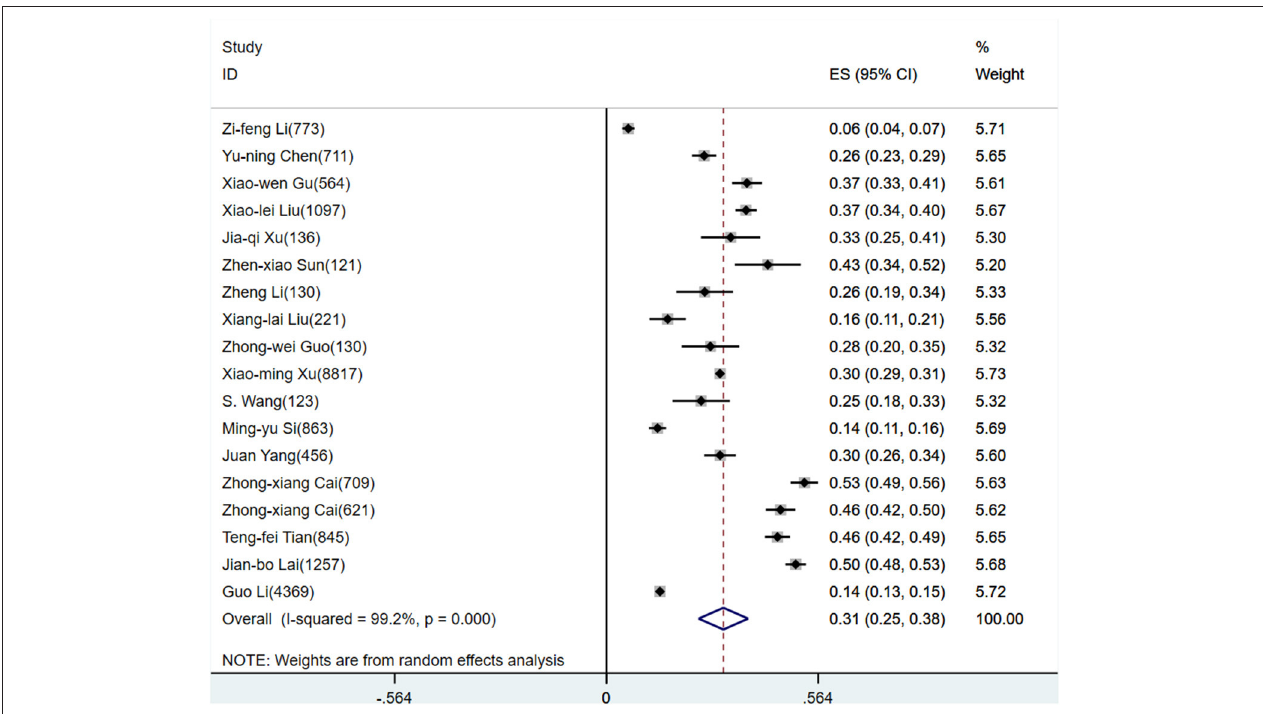
FIGURE 3 | Forest plot of depression prevalence in Chinese healthcare workers.